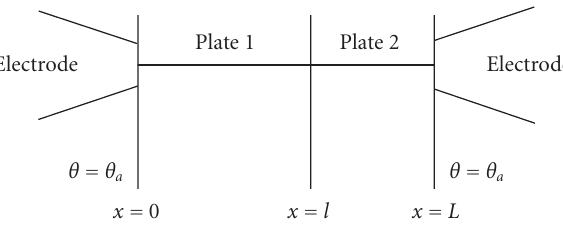
Figure 2.2. Expanded view of the plates and